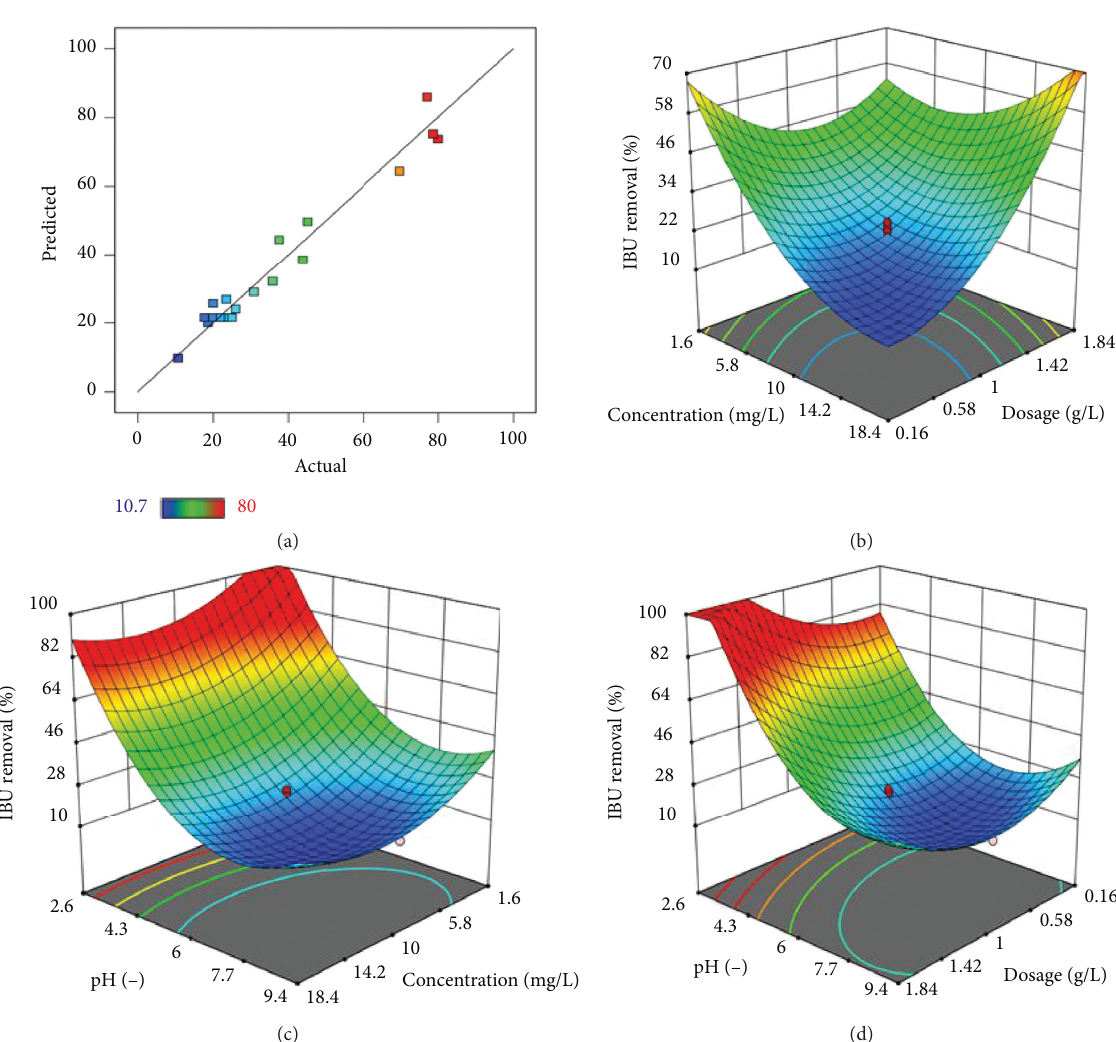
Figure 6: Actual versus predicted plots (a) and three-dimensional response surfaces (b)–(d) presenting the effect of factors on the